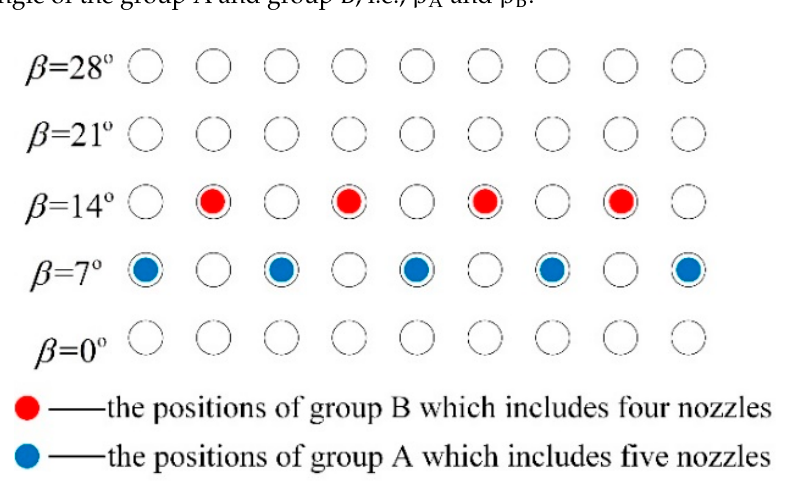
Figure 6. Schematic of the nozzle arrangement of group A and group B at the bottom of the bath.